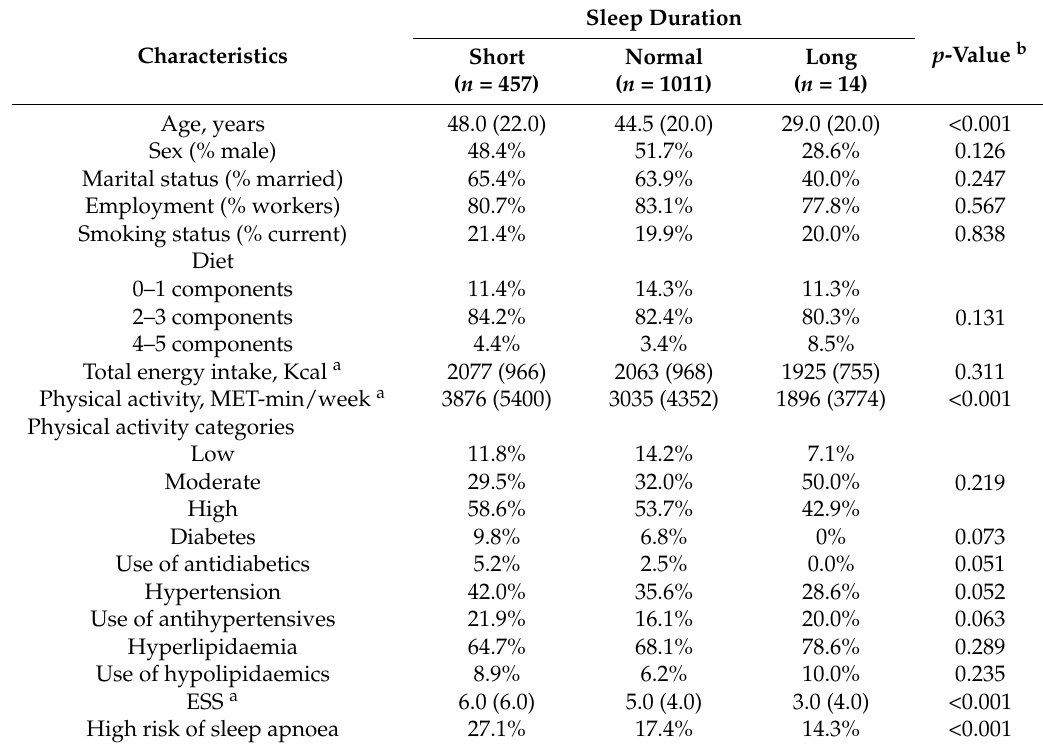
Table 1. Characteristics of study participants by categories of sleep